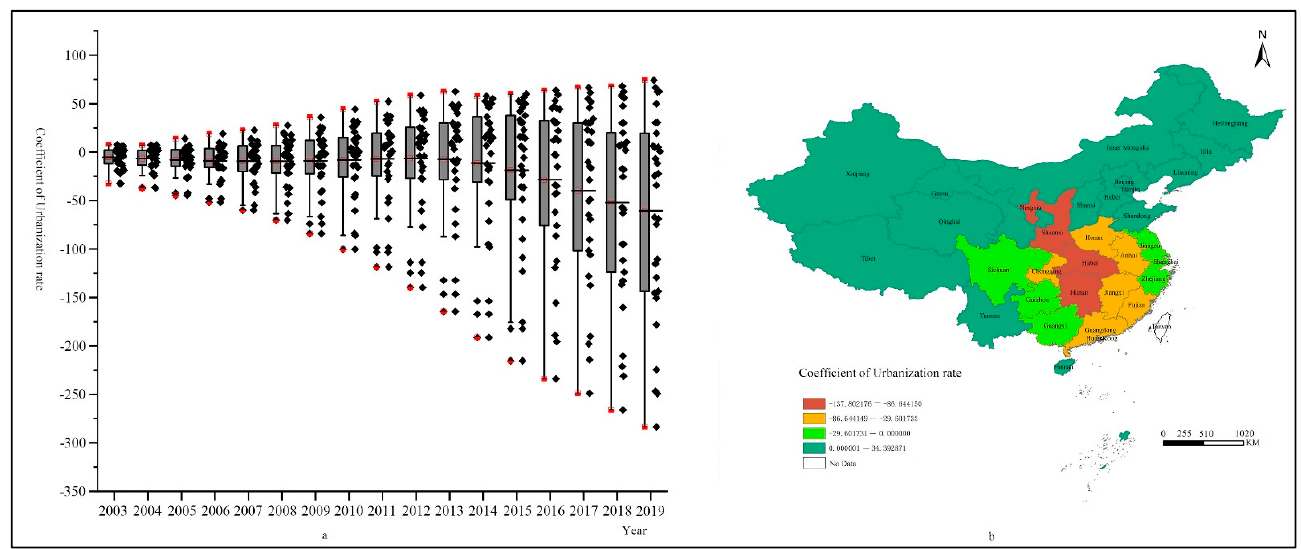
Figure 12. ( a ) Box-plot of regression coefficients of the urbanization rate; ( b ) Distribution of mean value of regression coefficients of the urbanization rate.